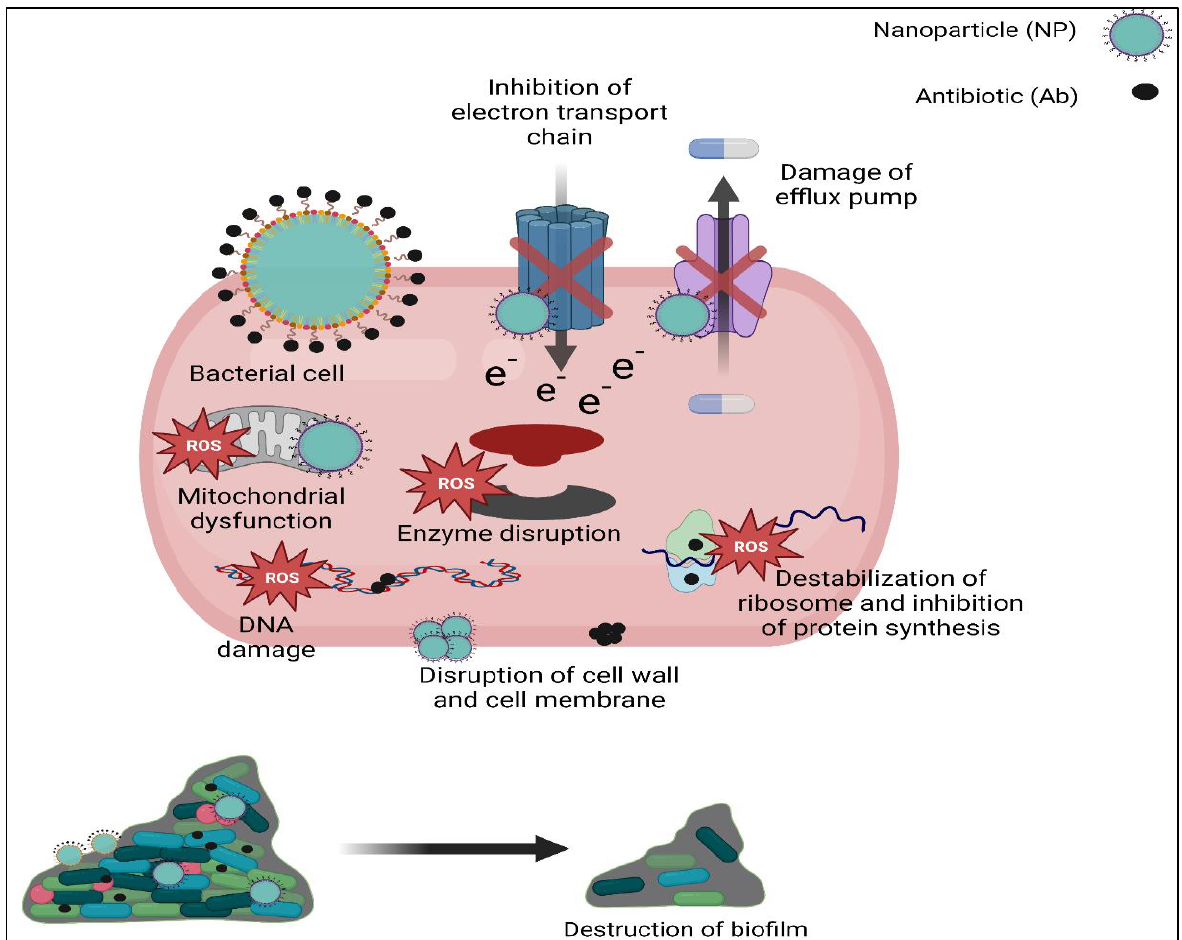
Figure 5. Synergistic activity of nanoparticles loaded with antibiotics. Combined nanoantibiotics (nAbs) exert dual antibacterial action through the effect of nanoparticles and antibiotics. Antibiotics can exert rapid and potent action through targeted delivery by NPs and exert their bactericidal effect through disruption of bacterial cell wall or cell membrane, destabilization of ribosomes and inhibition of protein synthesis or inhibition of nucleic acid synthesis. In addition, NPs can cause damage to bacterial cell wall, cell membrane, proteins, DNA, enzymes, mitochondria, efflux pump and inhibit electron transport and release reactive oxygen species (ROS) that cause damage to vital cellular